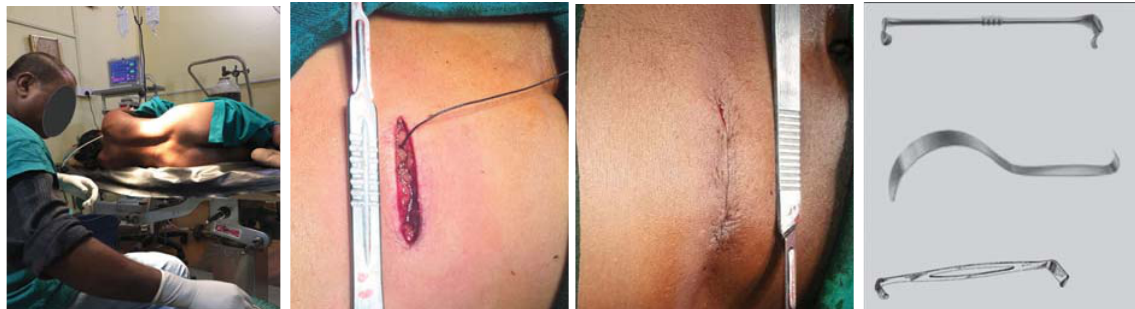
Figure 1A-D. Muscle-splitting mini-incision open-cholecystectomy- MC under spinal anesthesia (SA). A. SA L2-L3, non-invasive monitor, oxygen cylinder and basic general anesthesia set with halothane vaporizer and Benz (cid:70)(cid:76)(cid:85)(cid:70)(cid:88)(cid:76)(cid:87)(cid:3)(cid:82)(cid:81)(cid:3)(cid:86)(cid:87)(cid:68)(cid:81)(cid:71)(cid:69)(cid:92)(cid:30)(cid:3)(cid:37)(cid:17)(cid:3)(cid:36)(cid:3)(cid:21)(cid:91)(cid:21)(cid:91)(cid:21)(cid:3)(cid:191)(cid:81)(cid:74)(cid:72)(cid:85)(cid:3)(cid:85)(cid:76)(cid:74)(cid:75)(cid:87)(cid:3)(cid:86)(cid:88)(cid:69)(cid:70)(cid:82)(cid:68)(cid:86)(cid:87)(cid:68)(cid:79)(cid:3)(cid:87)(cid:85)(cid:68)(cid:81)(cid:86)(cid:89)(cid:72)(cid:85)(cid:86)(cid:72)(cid:3)(cid:48)(cid:38)(cid:3)(cid:70)(cid:79)(cid:82)(cid:86)(cid:72)(cid:71)(cid:3)(cid:76)(cid:81)(cid:3)(cid:79)(cid:68)(cid:92)(cid:72)(cid:85)(cid:3)(cid:90)(cid:76)(cid:87)(cid:75)(cid:3)(cid:70)(cid:82)(cid:81)(cid:87)(cid:76)(cid:81)(cid:88)(cid:82)(cid:88)(cid:86)(cid:3)(cid:86)(cid:88)(cid:87)(cid:88)(cid:85)(cid:72)(cid:3)(cid:11)(cid:85)(cid:82)(cid:88)(cid:81)(cid:71)(cid:3) needle 1/0 Polyglyconate earlier used for ligation of cystic duct & artery); C. Completion of subcutaneous skin suture; D.